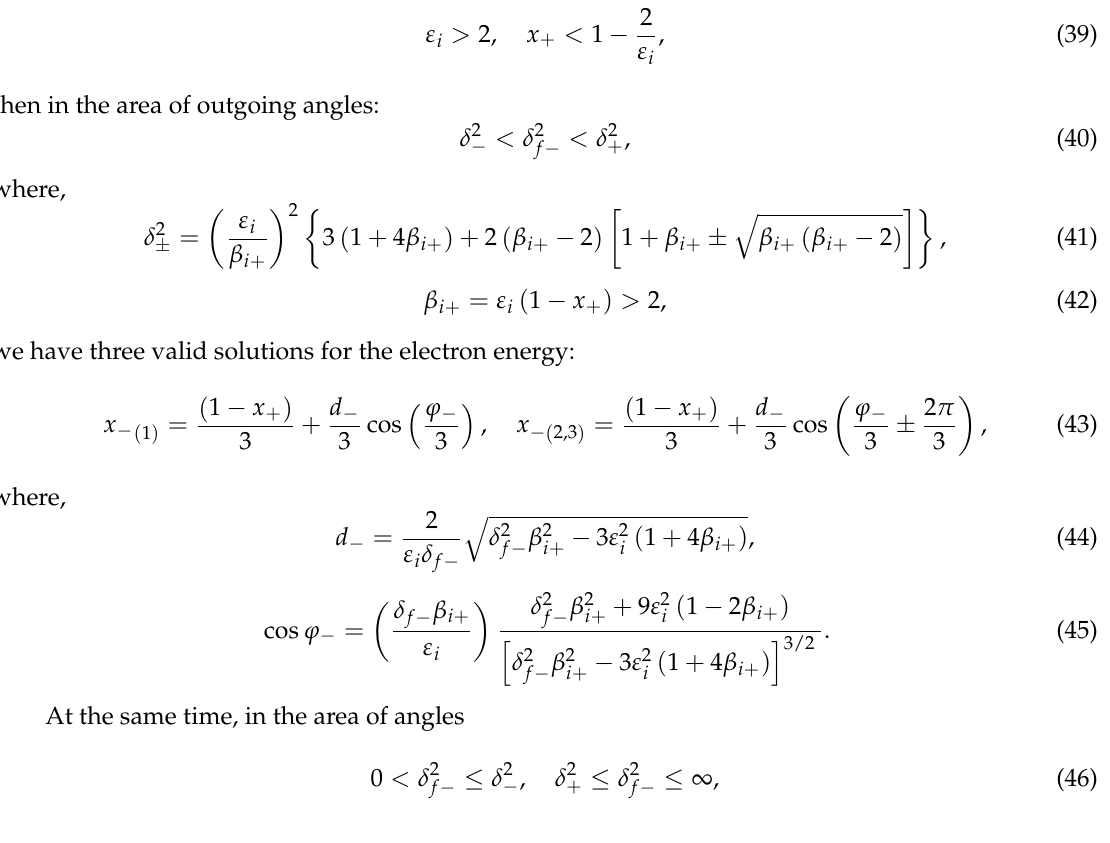
Figure 4. Dependence of the electron energy (in units of initial gamma quantum energy) on the δ 2 parameter for the energy of the initial gamma quantum E i = 150 MeV ( ε i = 1.5 ) . Curve 1 corresponds to the energy of the positron E + = 37.5 MeV ( x + = 0.25 ) , curve 2 is E + = 75 MeV ( x + = 0.5 ) with = the positron outgoing angle δ 2 + i